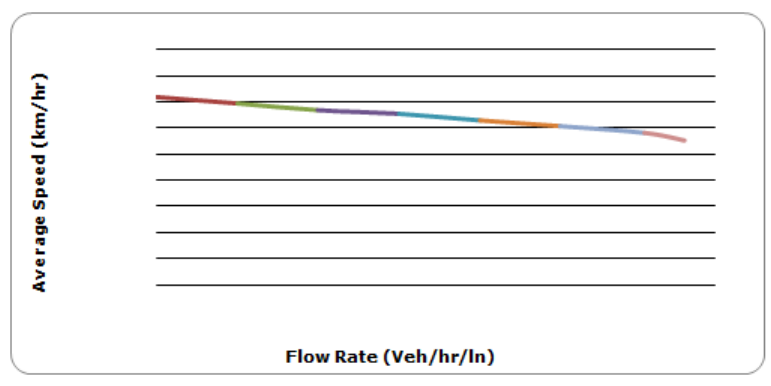
Figure 4. Speed-Flow Curves in the simulation model